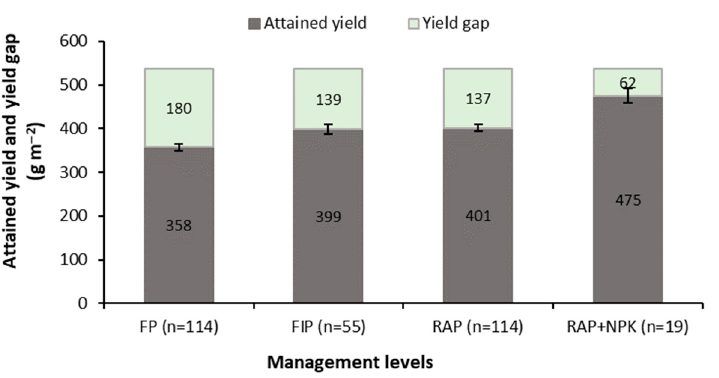
Figure 2. Attained yield (g m − 2 ) under different management levels and the corresponding yield gaps (g m − 2 ) on-farmers’ fields, Doho 2019. Error bars are twice standard error of means. FP = farmers’ practice, FIP = farmers’ intensification practice, RAP = recommended agronomic practices without fertilization, RAP+NPK = RAP combined with NPK fertilization.